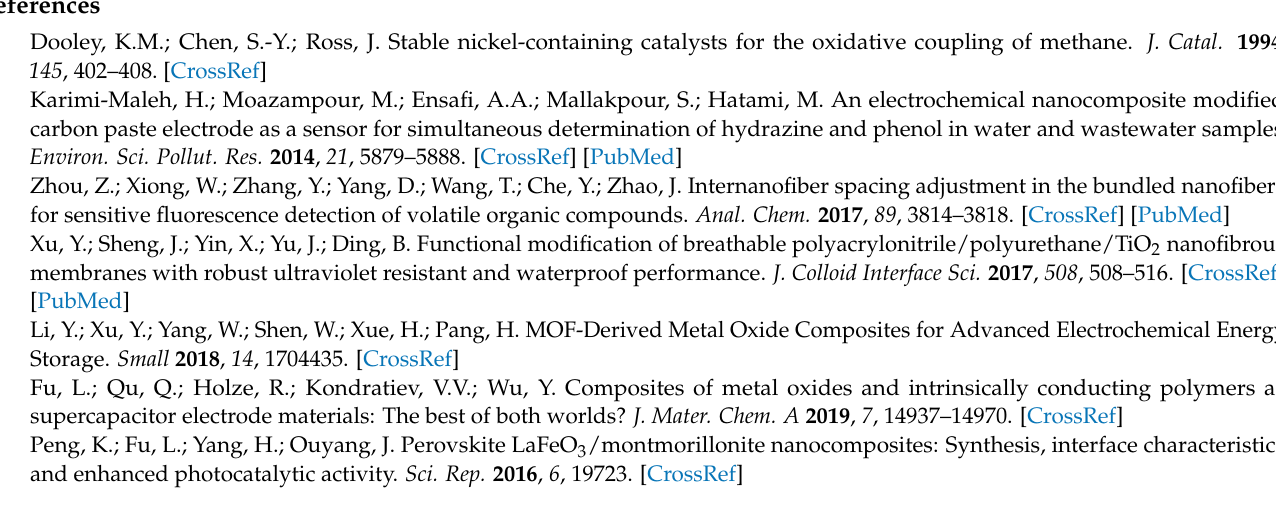
Figure S2: XRD pattern of the LaCoO 3 with 2:3 metal ratio, Figure S3: XRD pattern of the LaNiO 3 with 1:1 metal ratio, Figure S4: Photocatalytic degradation of MB and o-TB with 30% H 2 O 2 under visible light irradiation, (a) o-TB, (b) MB with a metal ratio of ratio